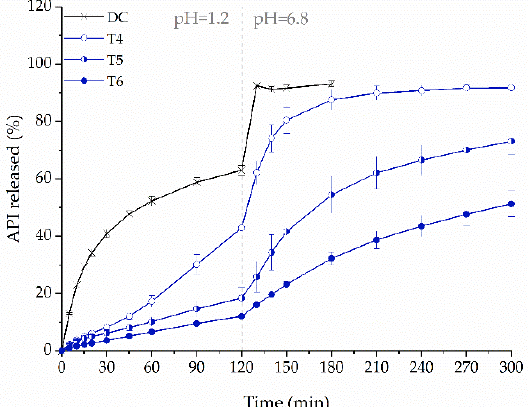
Figure 12. The influence of infill density on dissolution profiles of ketoprofen from directly com- pressed (DC) tablets and printlets made from F3 filament (dosage equal to 100 mg).